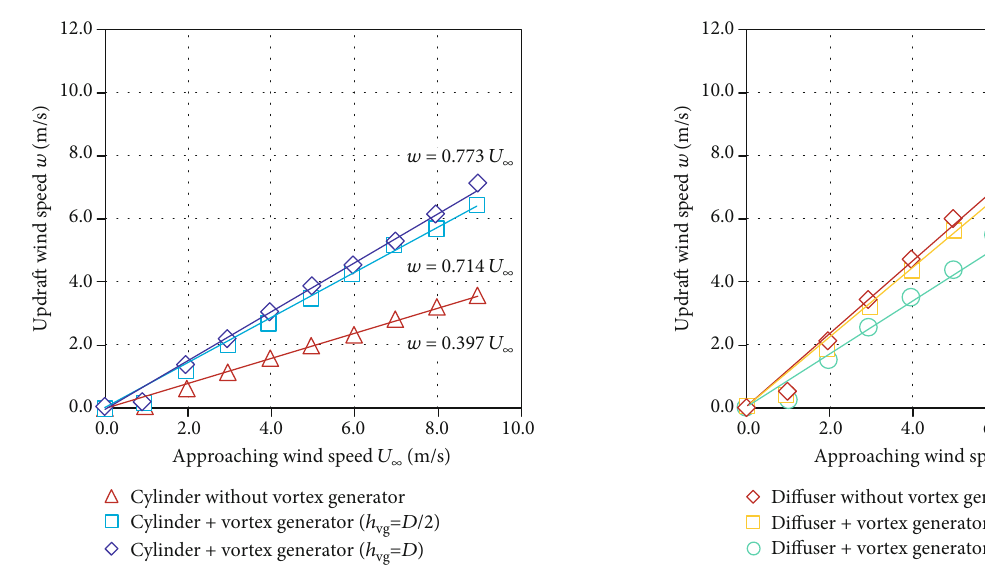
Figure 5: Updraft wind speeds in the case of the cylindrical tower (experimental results).